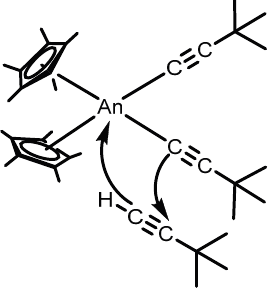
Figure 5. Regioselective insertion of t BuCCH into An–C bond. Adapted with permission from Haskel, A.; Straub, T.; Dash, A.K.; Eisen, M.S. J. Am. Chem. Soc. 1999 , 121 , 3014–3024 [53]. Copyright 1999 American Chemical